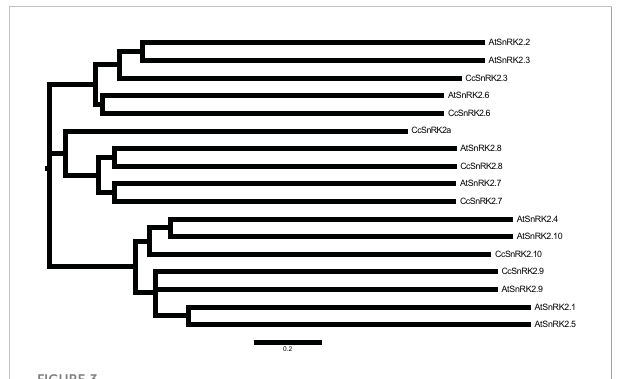
FIGURE 3 Phylogenetic tree of SnRK2 proteins from Citrus clementina and Arabidopsis thaliana CcSnRK2s: C. clementina ; AtSnRK2s: A. thaliana . The scale bar was the distance